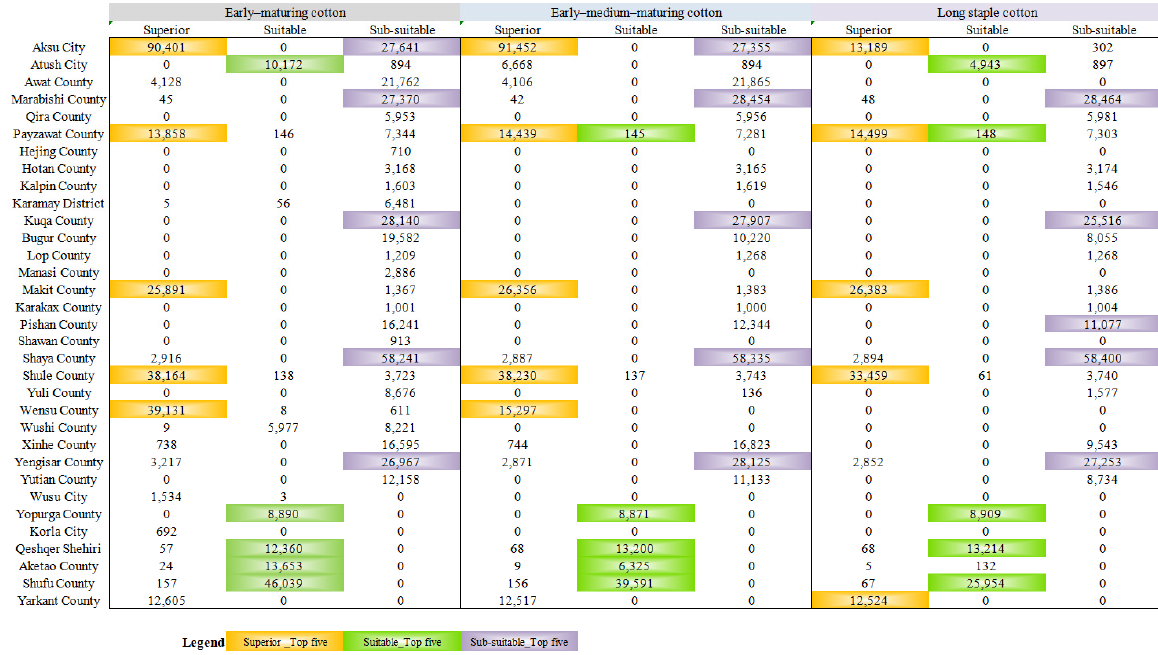
Figure 11. Spatial distribution of cotton seed production suitability: ( a ) early-maturing cotton; ( b ) early–medium-maturing cotton; ( c ) long staple cotton; ( d ) comprehensive suitability of cotton seed production. Table 2. Suitable for the three varieties of cotton seed production area (unit: ha).